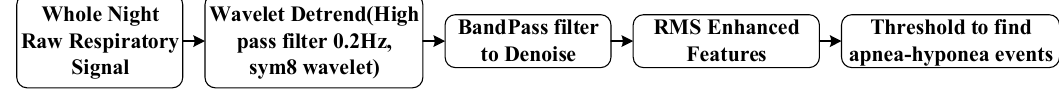
Figure 10. Feature extraction algorithm for apnea and hypopnea events.